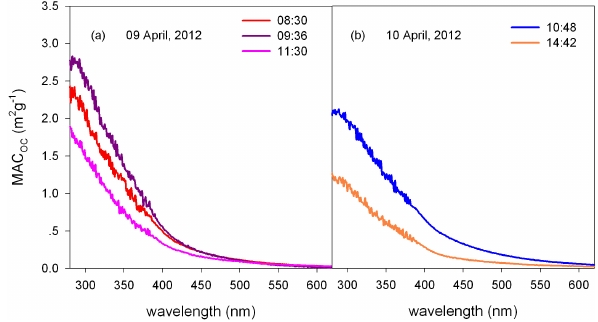
Fig. 6. Light absorption of ambient biomass-burning OA sampled during the County Line wildfire event on 9 April 2012 (a) and 10 April 2012 (b) at different sampling